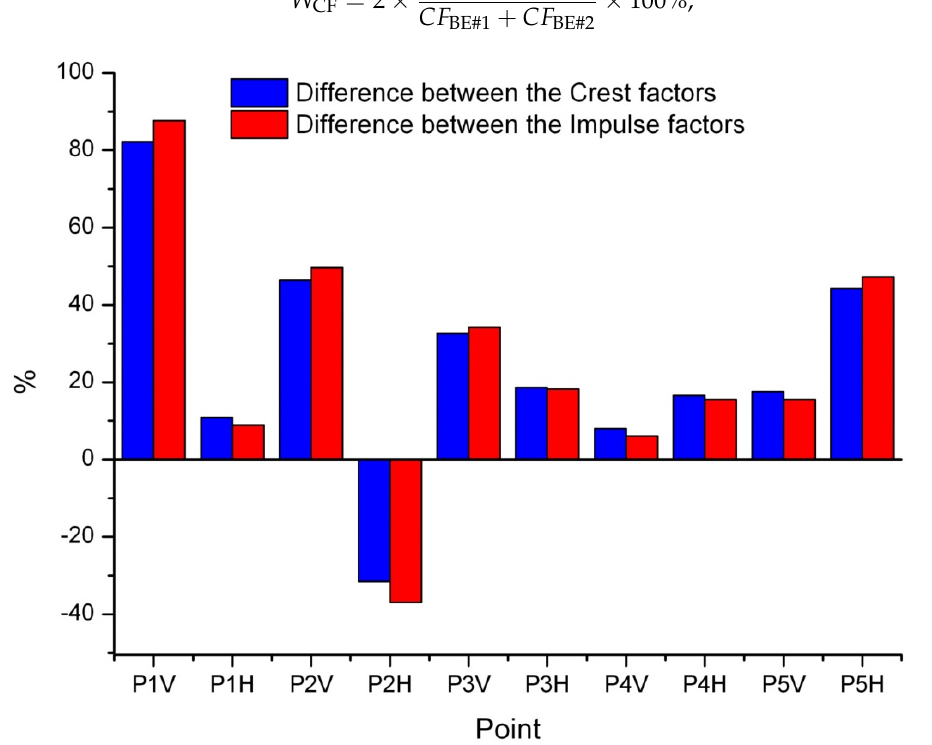
Figure 8. Relative differences between the Crest factor and the Impulse factor of vibration velocity at the measuring points of the tested drive